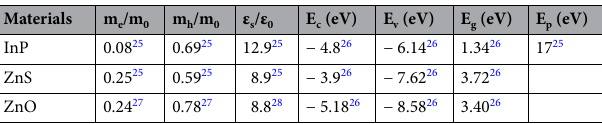
Table 1. Materials parameters used in the calculations.